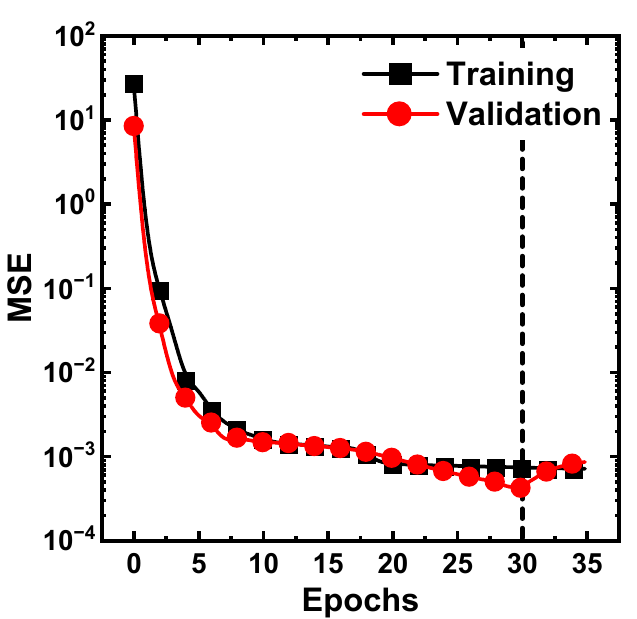
Figure 5. Example of MSE vs. epochs in the training and validation sets. MSEs were used as a measure of training. The model adopted five-fold cross validation later used to evaluate the test sets.